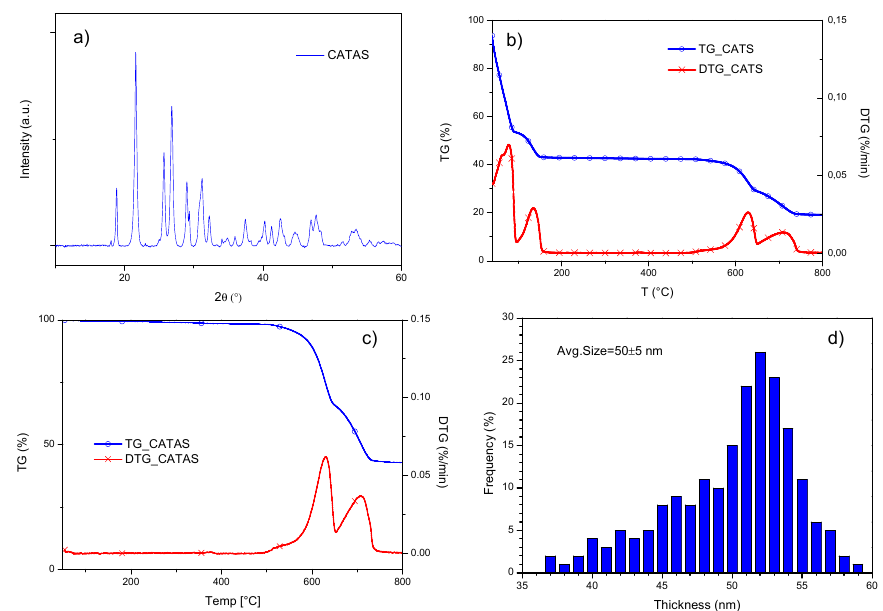
Figure 2. XRD profile for CATAS ( a ); TG / DTG curves for CATS ( b ); and CATAS nanofillers ( c ); thickness distribution for CATAS ( d ).